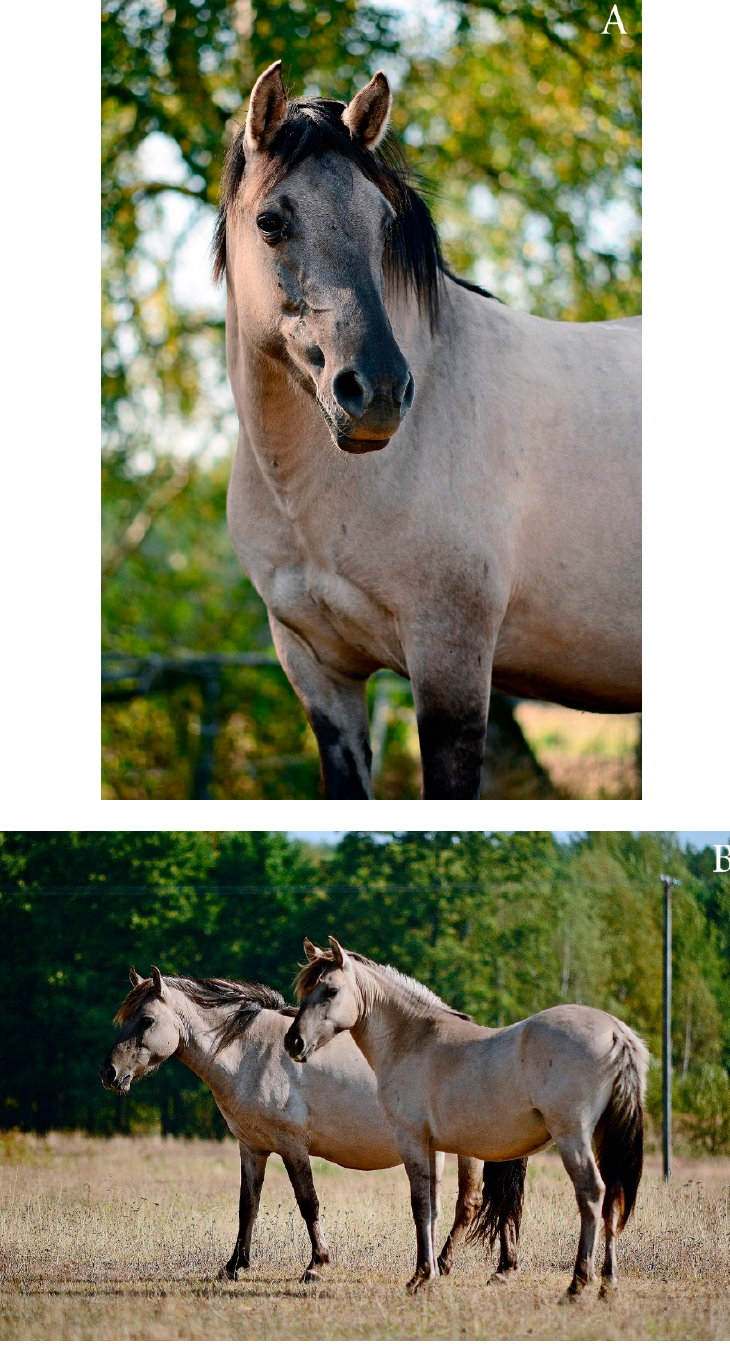
Figure 1. ( A ) Polish Konik; ( B ) appearance of Polish Konik (photo by Paulina Peckiel). Due to maternal and paternal line analyses indicating that their uneven representation (according to Jaworski (Jaworski, 1997 in [17])) [17] and the relatively small population of Polish Konik horses, the genetic variability of this breed should be monitored, especially given that their present genealogical statistics are unknown. Polish Konik horses, which are unique, natural-breeding relicts, must be preserved as a specific reservoir of genetic resources for future breeding work